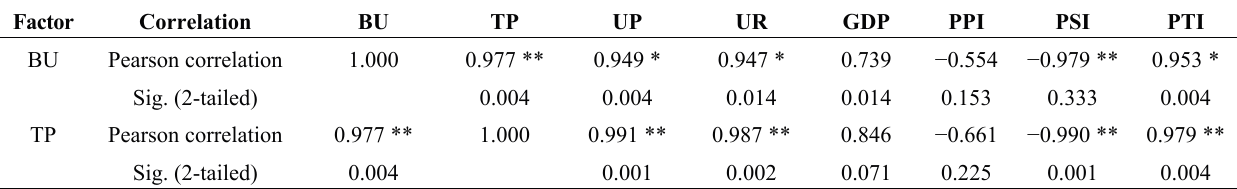
Table 9. Correlations between the built-up areas and socioeconomic